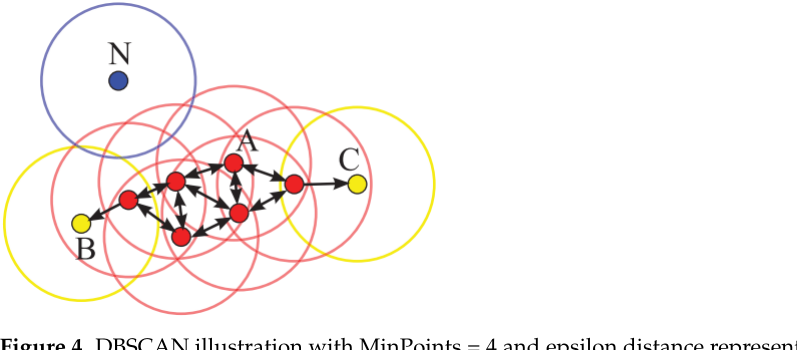
Figure 4. DBSCAN illustration with MinPoints = 4 and epsilon distance represented by circles. Core points, such as A, are represented in red, B and C, in yellow, are border points, and N is a noise point, represented in blue. From